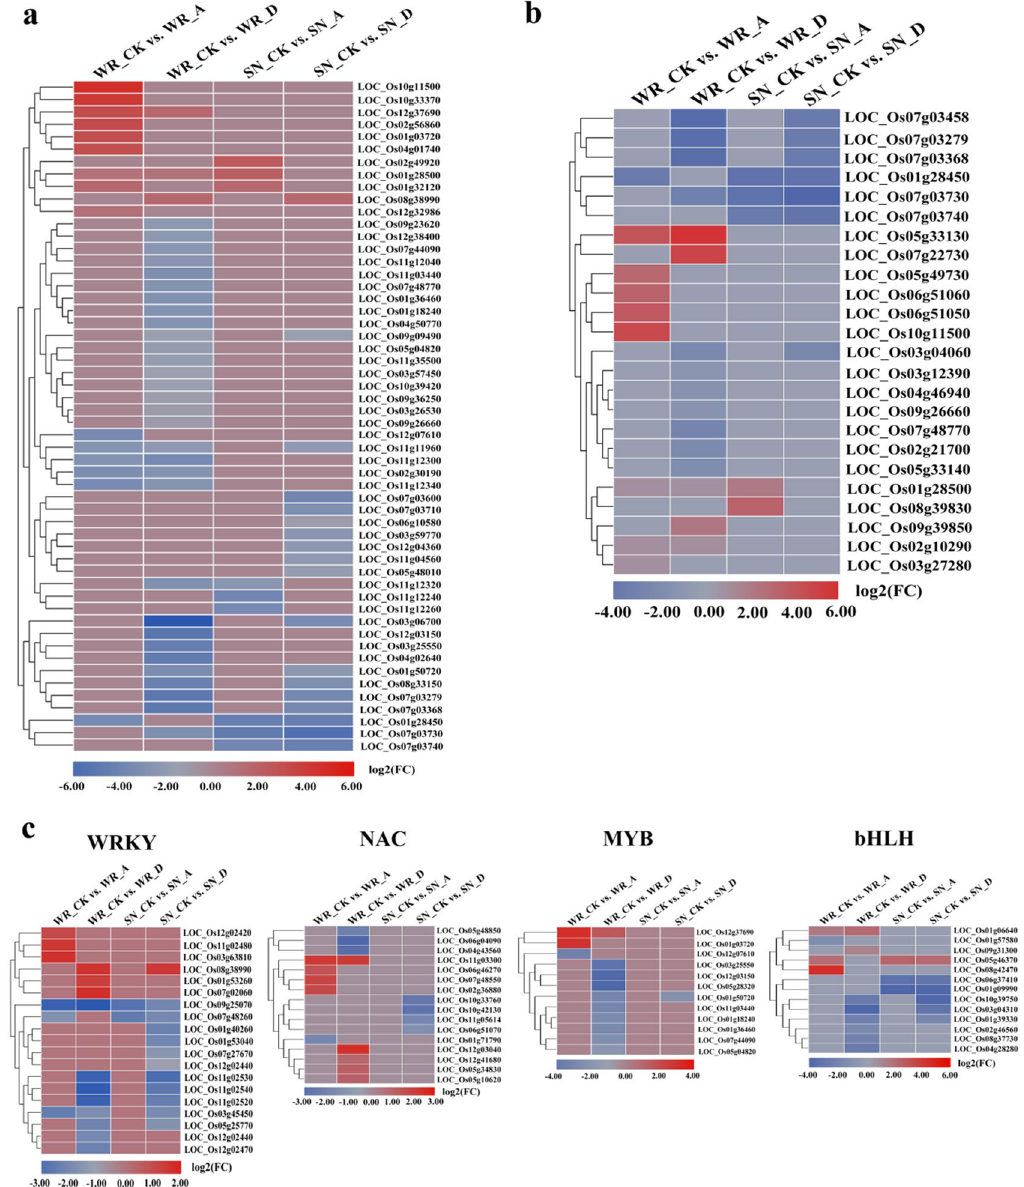
Figure 6. Expression profiles of defense-related genes in WR04-6 and SN9816 plants after exogenous treatments. Comparative analysis of pathogen interactions ( a ), MAPK signaling pathway transduction ( b ), and the expression of transcription factor related genes ( c ) in WR04-6 and SN9816 plants after exogenous treatment. Gene expression levels were transformed by log 2 (FPKM) values. Red and blue represent up-regulation and down-regulation, respectively. A in WR_A or SN_A indicates ABA treatment, D in WR_D or SN_D indicates diniconazole treatment, and CK in WR_CK or SN_CK indicates the control group without